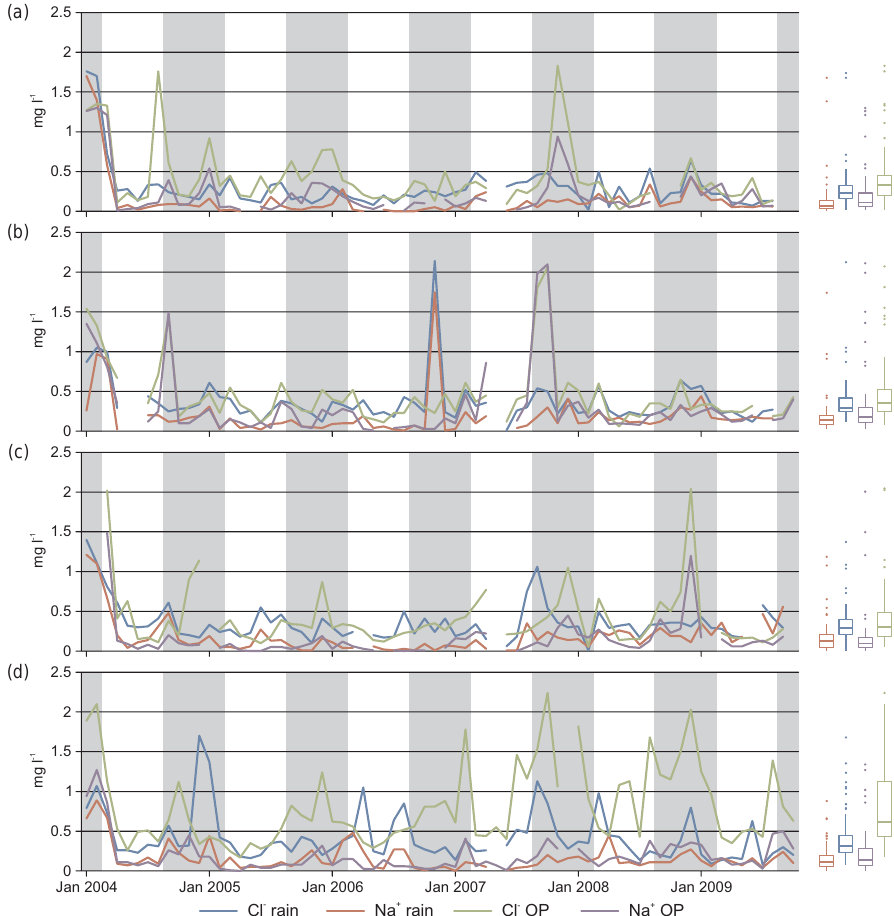
Figure 2. Time series of Na + and Cl − VWMM concentration in rain and OP. These samples come from MSs at different altitudes and topographical locations: (a) Cerro del Consuelo (3180m), (b) El Tiro (2825m), (c) TS1 (2660m), and (d) ECSF (1960m). The shaded areas cover 6-month periods from September to February. The boxplots in the right column show the distribution of each time series: boxes symbolize the lower and upper quartile of the data, vertical lines show ranges of observed concentration, and points are